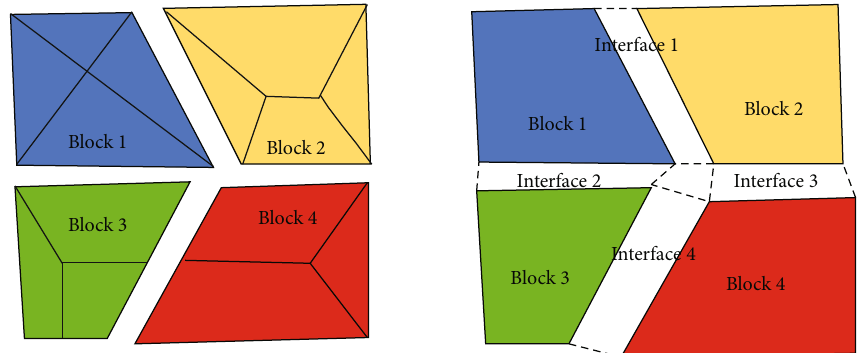
Figure 1: Block and interface elements of the CDEM.